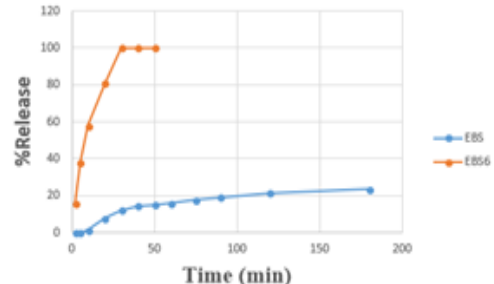
Figure 5. The release profile of pure drug (EBS) and SCAs (EBS6) in in 0.1 NHCl at 37°C Micromeritic property The values of angle of repose, Carr’s index and Hausner ratio of pure drug and SCAs of EBS are shown in table 3. High value for angle of repose of untreated EBS (47.27°±0.047) indicated poor flowability of the drug due to its irregular crystals which hindered their flowability from funnel in comparison with the formulated SCAs. The significant improvement (p<0.05) in flowability for SCAs of each formula in comparison with untreated EBS as indicated by the low values of angle of repose was due to their spherical shape and smooth surface, which results in reduction in the interparticle friction since the area of contacts for spherical shape was smaller than that for other particle shape (42) .Carr’s index and Hasnurs’ ratio were of highest value for untreated EBS compared to the prepared SCAs that’s mean poor compressibility and packability pure drug. These properties were also improved by formulation of SACs due to their spherical shape